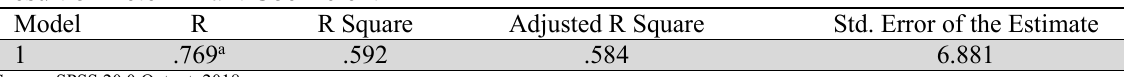
Result of Determinant Coefficient 2